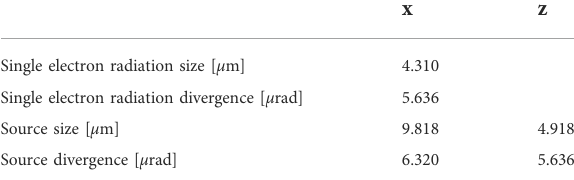
TABLE 2 Parameters of X-ray light source at 10 keV for low beta